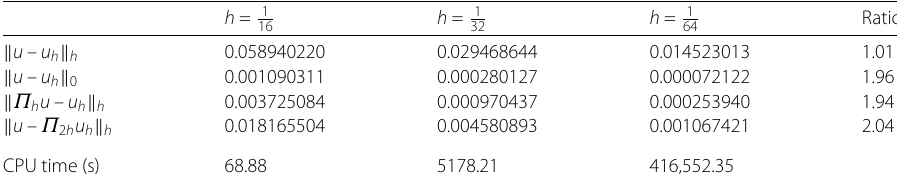
Table 2 Numerical results of the usual Galerkin FEM at t = 1 ( τ = h 2 )